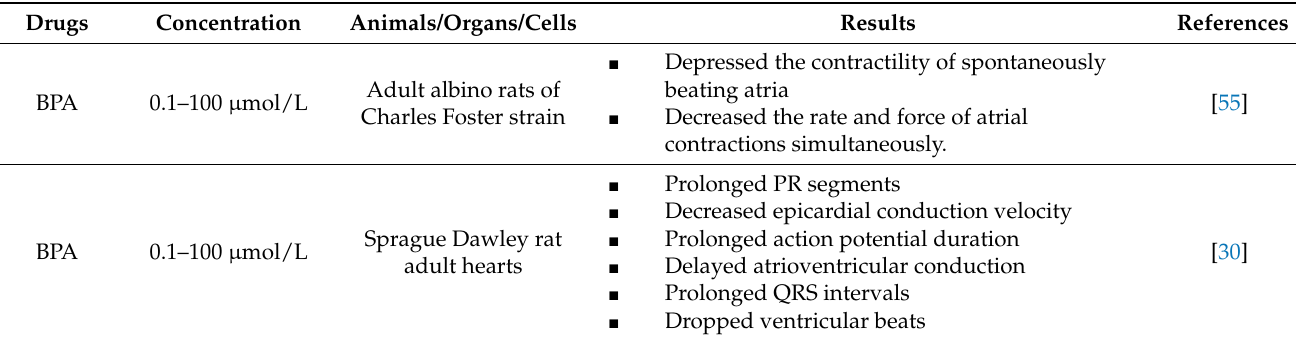
Table 2. Summaries of the disruptive effects of BPA in animal ex vivo studies 1